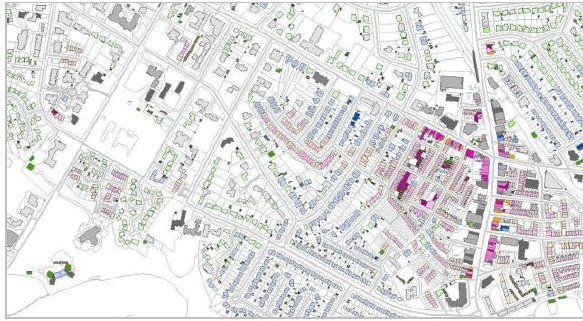
Figure 4. An example for Level 3 building classification